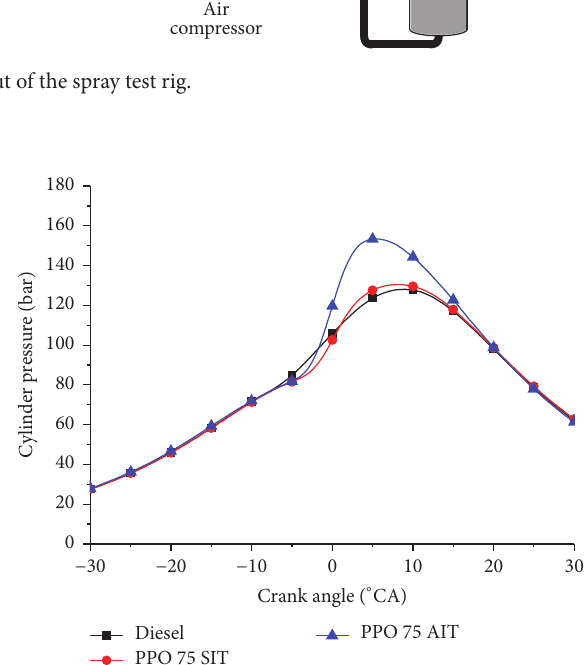
Figure 3: Variation of cylinder pressure with crank angle at 75%